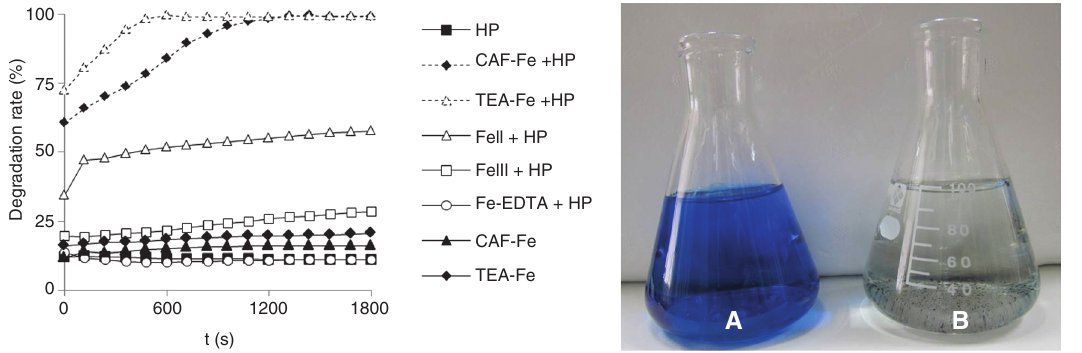
Figure 6 Effect of ‘green’ Fe catalysts and 10 mm hydrogen peroxide (HP) on degradation rate of 0.017 mm methylene blue (MB). Deg- radation rate versus time of MB with 10 mm HP, MB with 0.1 mm Fe as CAF-Fe and 10 mm HP (CAF-Fe+HP), MB with 0.1 mm Fe as TEA-Fe and 10 mMHP (TEA-Fe+HP), MB with 0.1 mm Fe as ferrous chloride tetrahydrate (FeII+HP), MB with 0.1 mm Fe as ferric chloride anhydrous (FeIII+HP), MB with 0.1 mm Fe as Fe-EDTA (Fe-EDTA+HP), MB with 0.1 mm Fe as CAF-Fe only (CAF-Fe) and MB with 0.1 mm Fe as TEA-Fe (TEA- Fe). The picture shows (A) HP and (B) TEA-Fe+HP treatments, respectively.